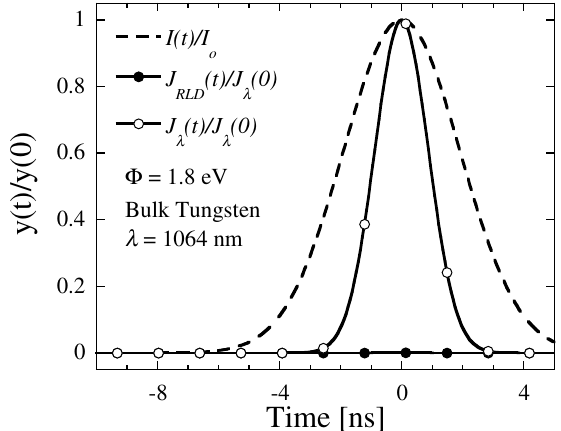
FIG. 16. Same as Fig. 15, but for long wavelength (1064 nm), work function of a scandate cathode, (cid:18) E (cid:3) 1 : 0 mJ , and (cid:18) t (cid:3) 2 : 7 ns .